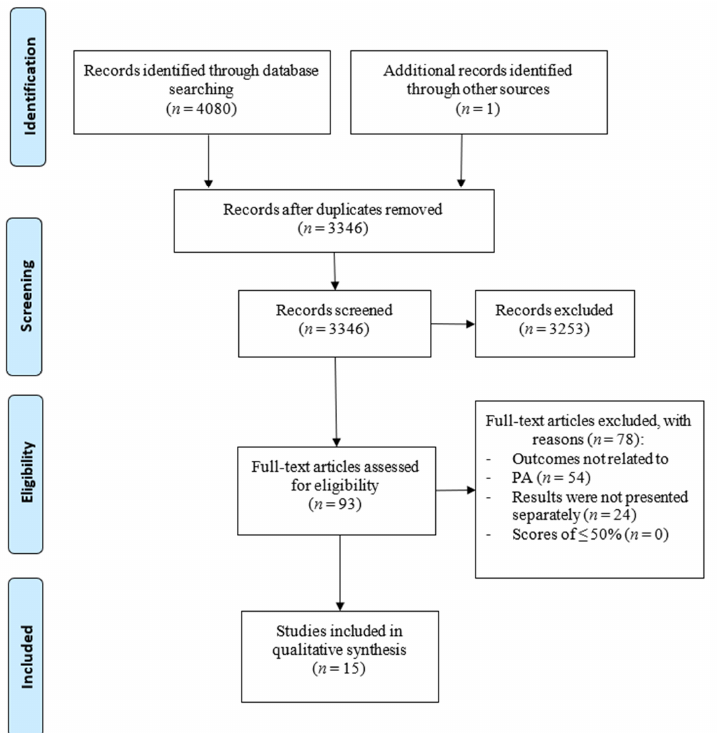
Figure 1. Study selection process. PA—physical activity.